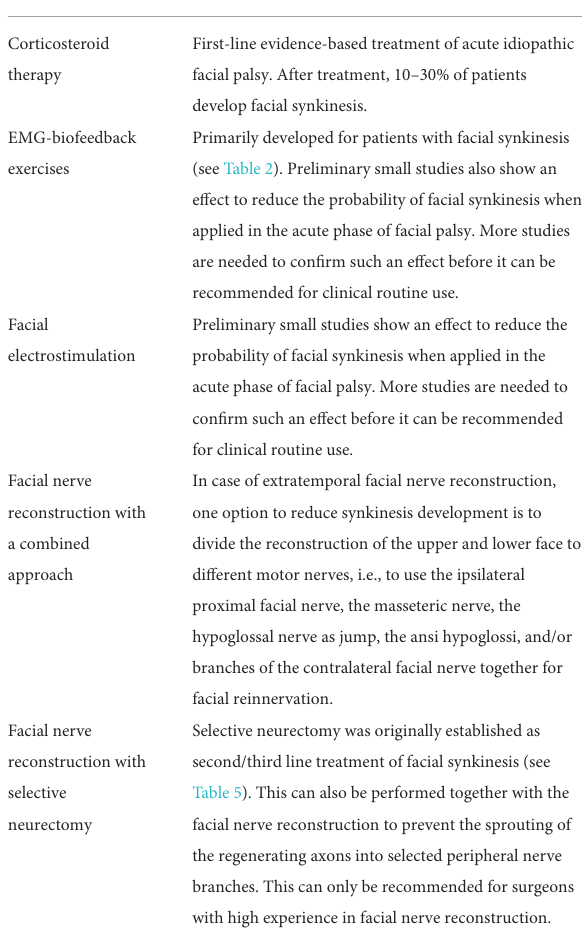
TABLE 3 Most important measures to prevent facial synkinesis based on this